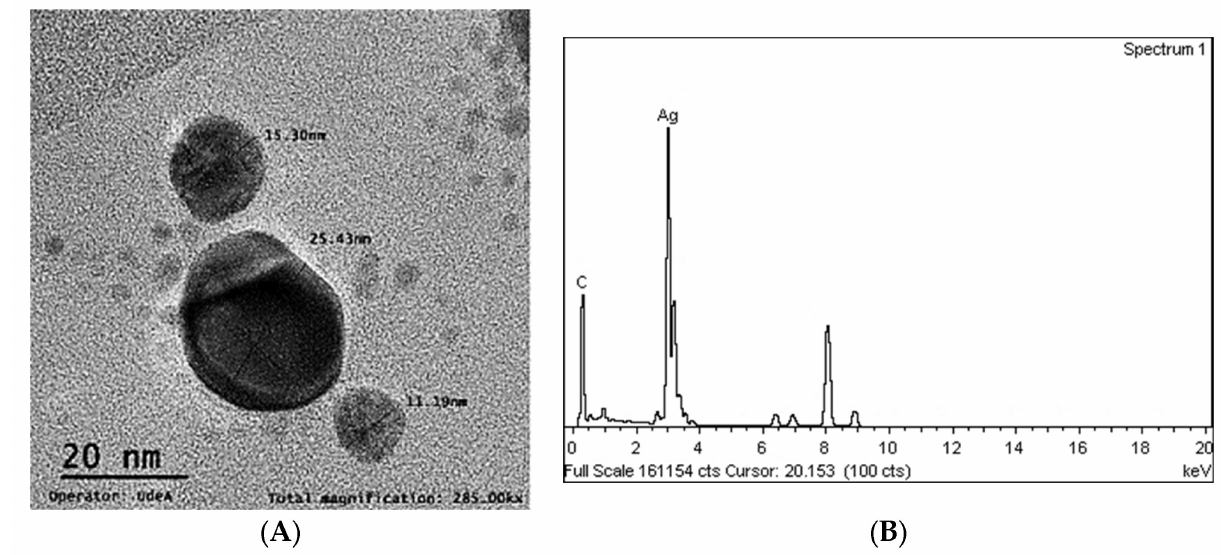
Figure 3. ( A ) TEM micrograph of Ag-NPs. ( B ) EDX